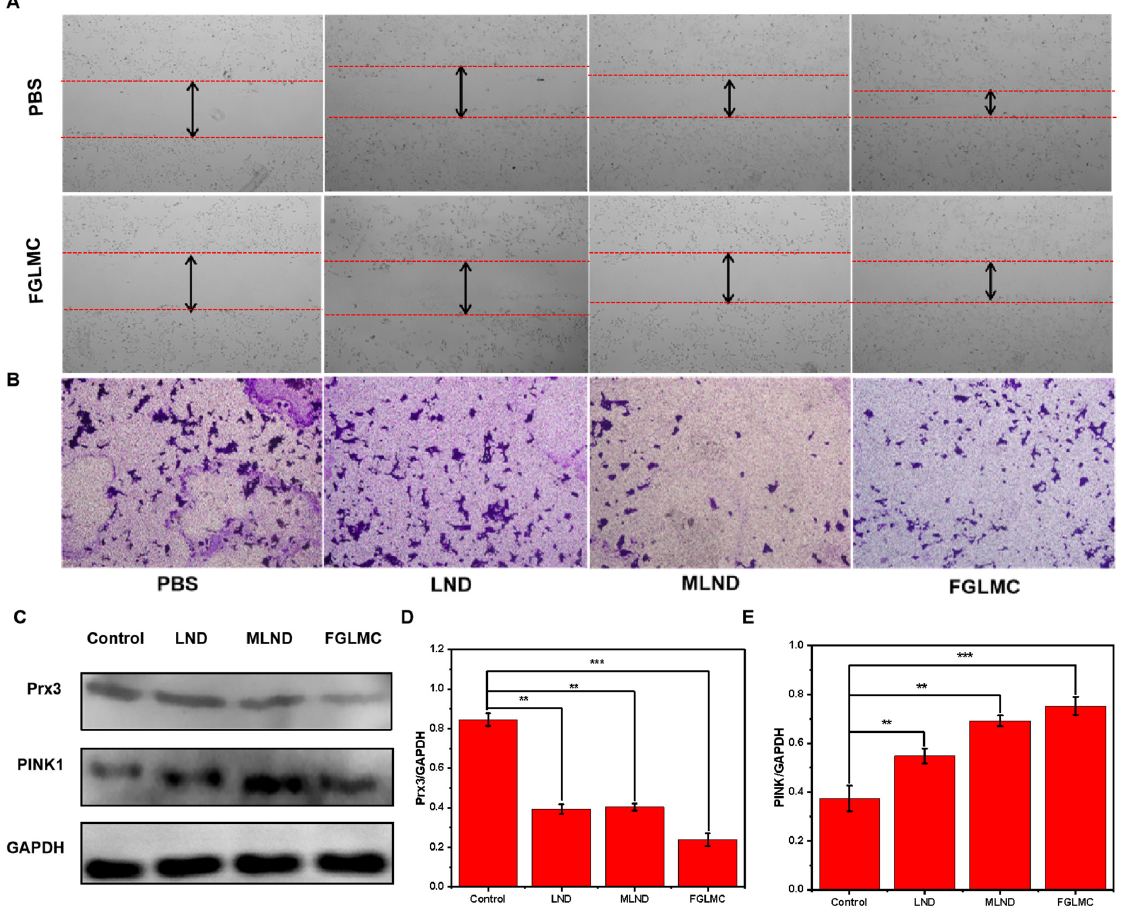
Figure 5. Migration and invasion evaluation. ( A ) Wound healing assay and ( B ) anti-invasion effects of different formulations on MCF-7 cells (The distance between the red dotted lines is the cell spacing after different treatments). ( C ) Western blot analysis for the expression of Prx3 and PINK1 on MCF-7 cells treated with different formulations. GAPDH was used as the loading control. Quantification of Prx3 ( D ) and PINK1 ( E ) expression intensity. Data are presented as mean ± SD (** p < 0.01, *** p <